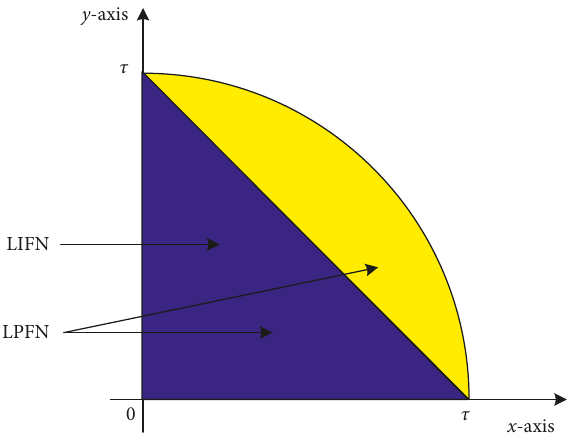
Figure 1: The distribution areas of LIFN and